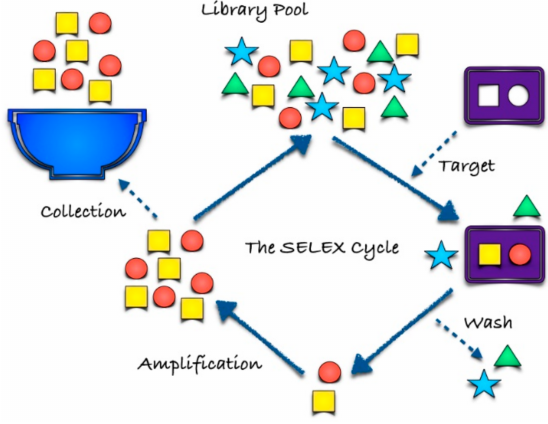
Figure 1. Schematic view of the SELEX